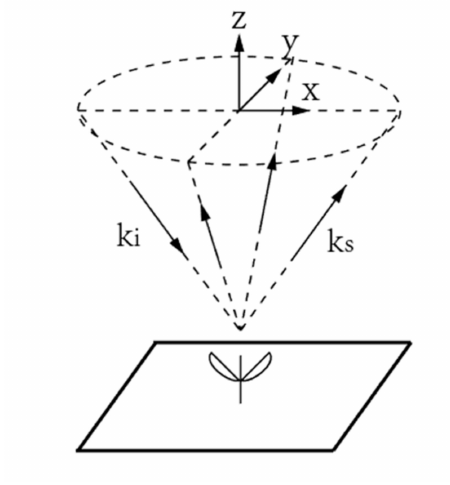
Figure 7. Specular cone.